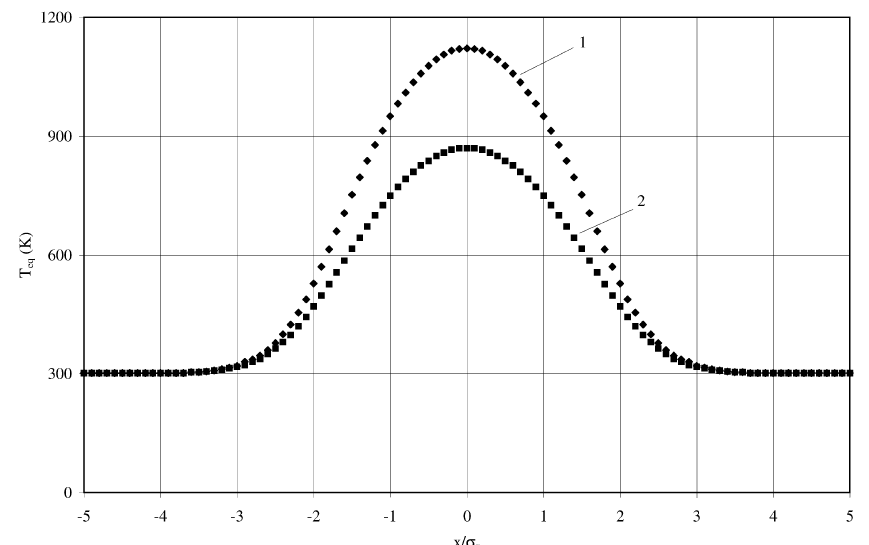
FIG. 3. Wire equilibrium temperature T eq at different distances of the wire from beam center, d 1 (cid:1) 30 m m, d 2 (cid:1) 10 m